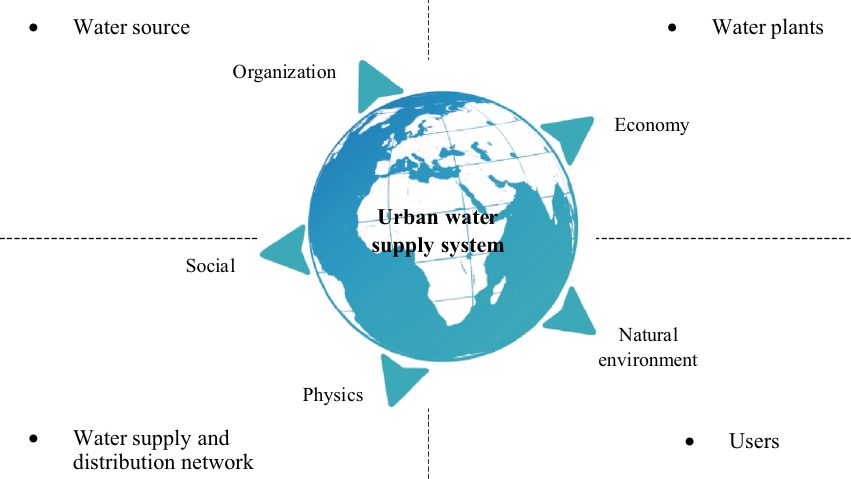
Figure 2. Urban water supply systems (the figure shows four dimensions of whole-process water supply system and five dimensions of urban management